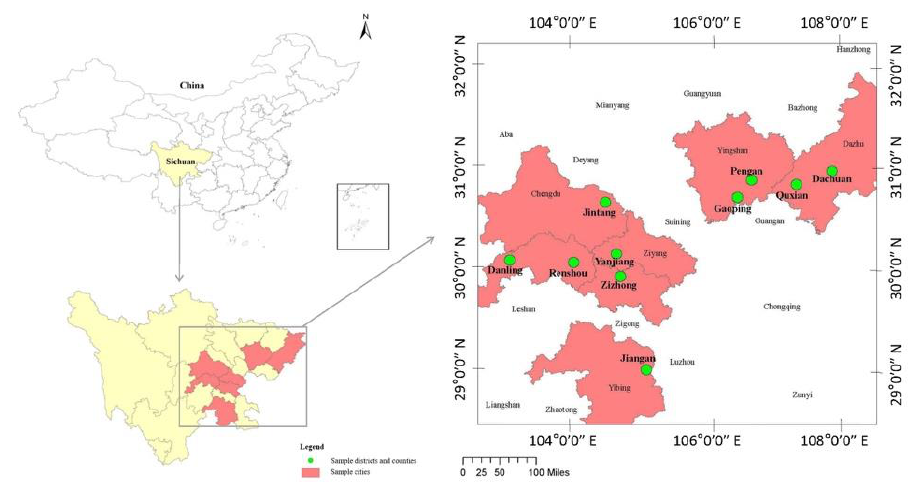
Figure 2. Distribution of sample counties.